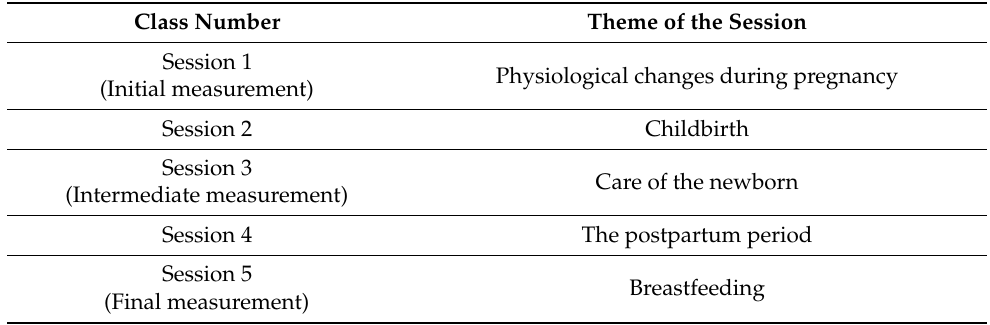
Table 1. Schedule of sessions of the Maternal Education Program of the health service received by pregnant women participants. Class Number Theme of the